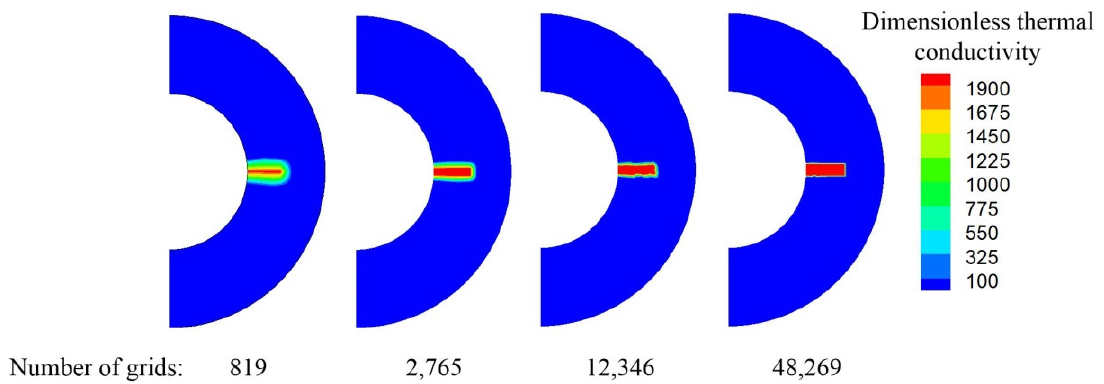
Figure 3. Effect of the number of grids on the distribution of dimensionless thermal conductivity.